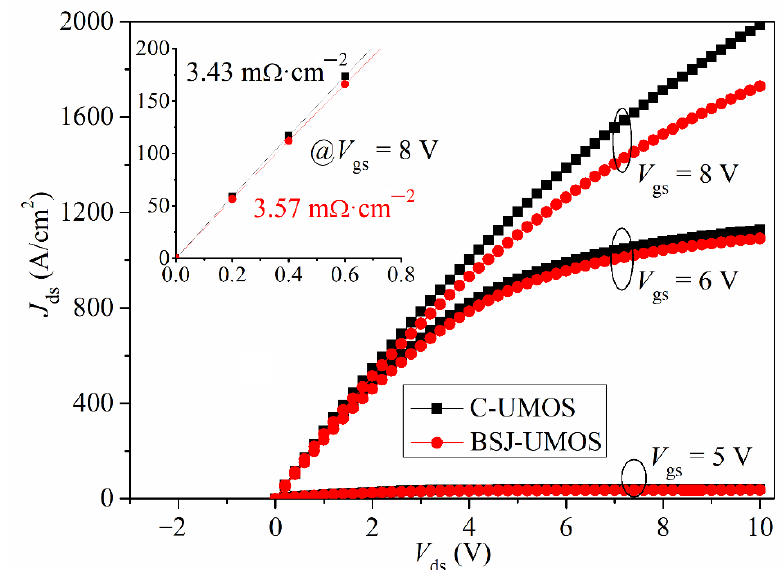
Figure 3. Comparison of I-V characteristic curves.